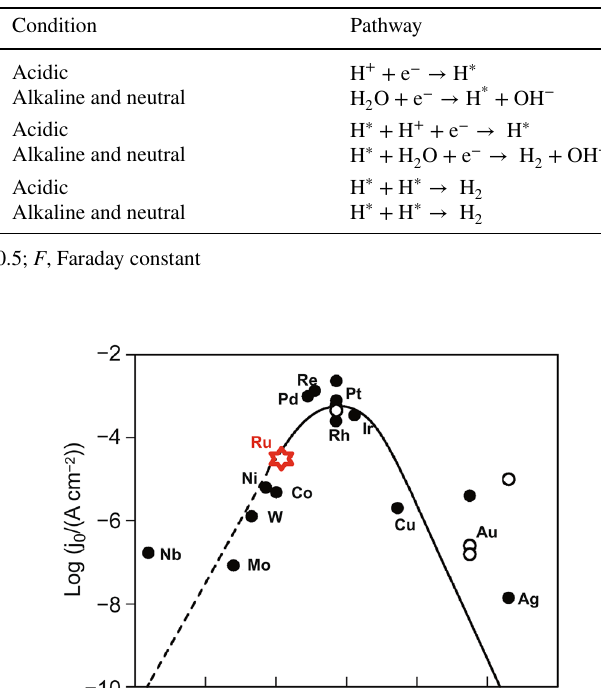
Table 1 Possible reaction pathways of HER under acidic, alkaline and neutral conditions